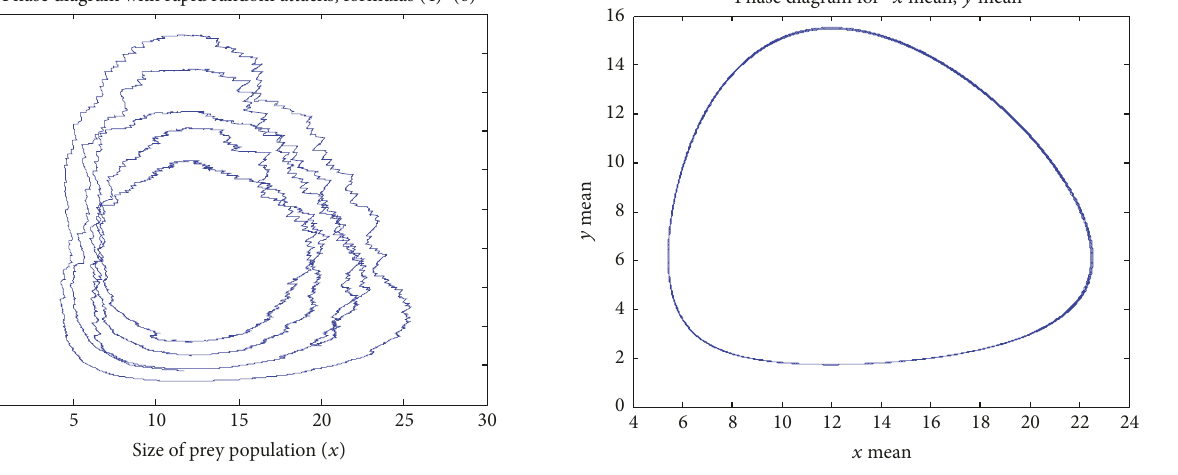
Figure 1: Phase trajectory of Markov process (4)-(5)-(6). Figure 2: Limit cycle of dynamical system (1).